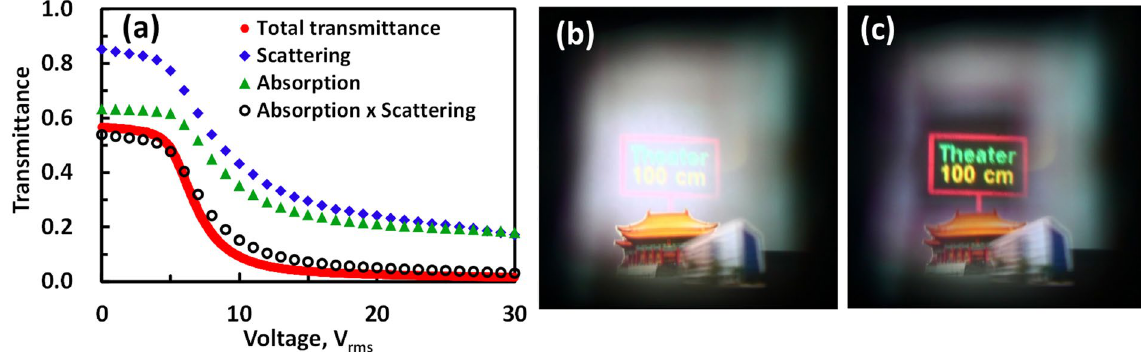
Figure 8. The electro-optics property of the attenuator and images taken with from an environment with strong ambient light. ( a ) The transmittance as a function of applied voltage at D = 15 cm at λ = 532 nm. Red line stands for the total transmittance. The blue diamonds represent the experiment results of transmittance due to light scattering. The green triangles represent the experiment results of transmittance due to light absorption. The hollow circles represent the calculated total transmittance from light absorption and light scattering. Images was recorded under a strong ambient light when ( b ) the LC attenuator was off and ( c ) the LC attenuator was on (30 V rms ; f = 1 kHz). An unpolarized light was used. The “ NCTU building” is imaged by Pi Cheng Wu and the copyright is released to the authors and Nature Publishing Group. The “Theater” is photographed by Fred Hsu and distributed under license of CC BY-SA 3.0 (https://creativecommons.org/licenses/by-sa/3.0/) on https:// en.wikipedia.org/wiki/National_Theater_and_Concert_Hall,_Taipei#/media/File:Taiwan_2009_Taipei_